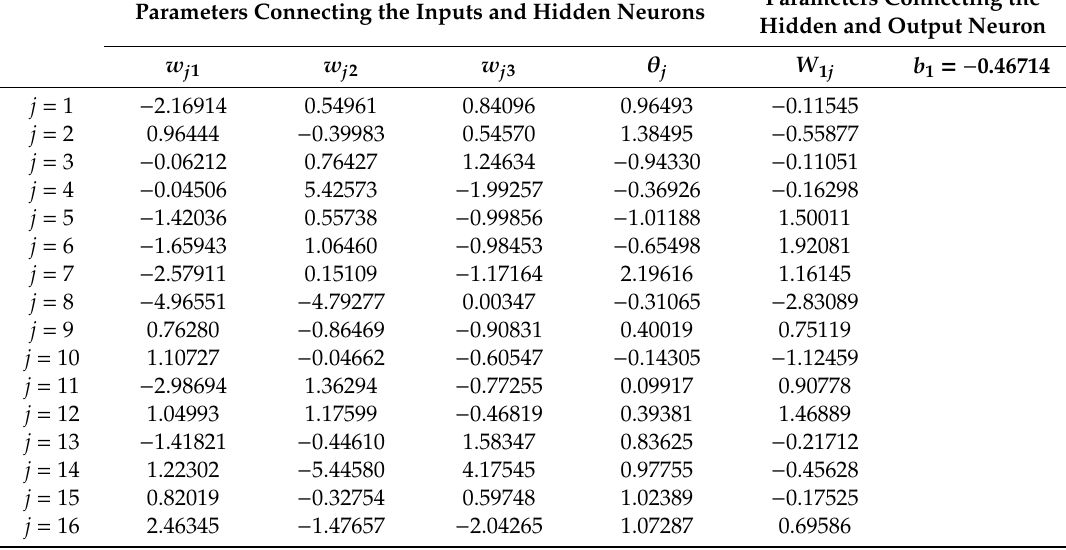
Table 2. Optimized parameters (weights and bias) of the feedforward neural network. Parameters Connecting the Inputs and Hidden